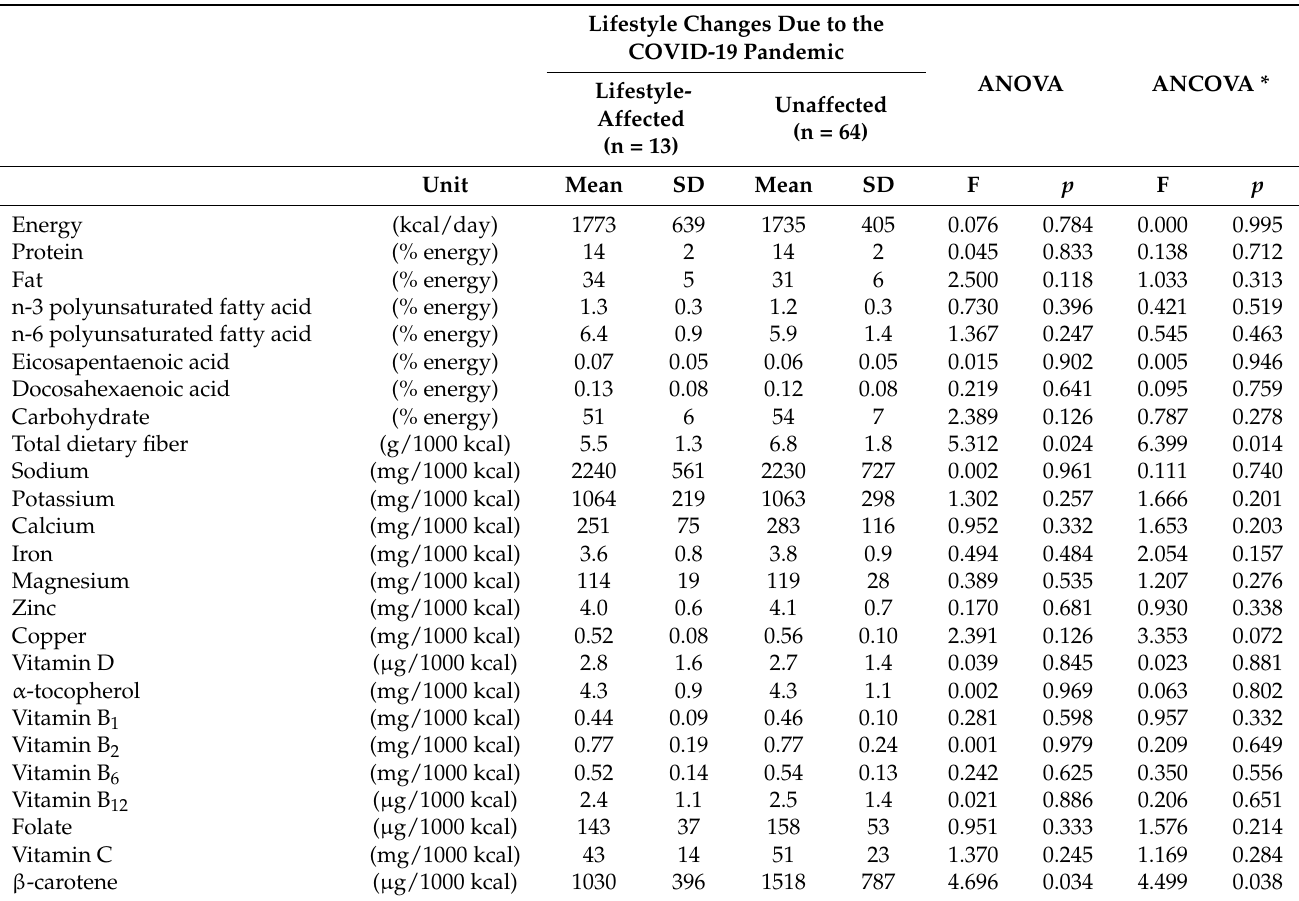
Table 4. Differences in nutrient intake between the lifestyle-affected and unaffected groups in multiparas (n = 77).